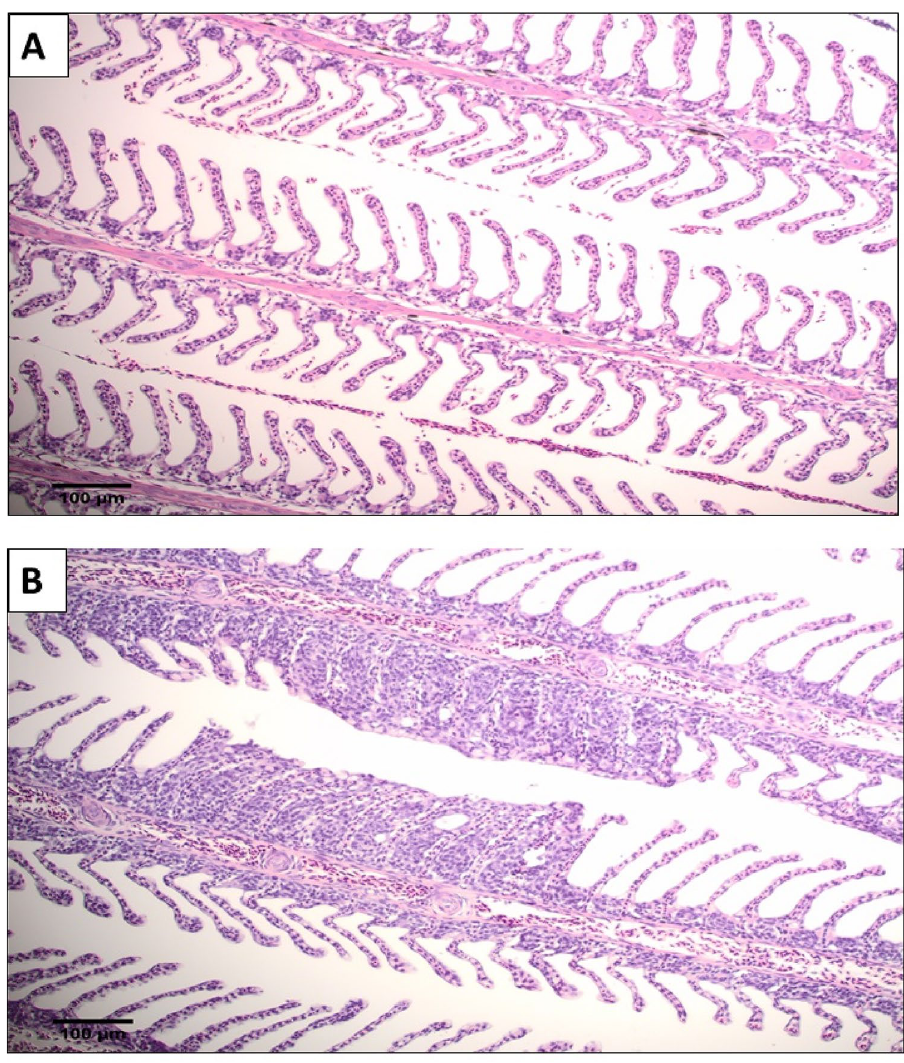
Figure 1. An example of H&E stained gill samples taken from non-AGD and AGD infected fish from the challenge trial. Scale bar = 100 µm. ( A ) Gill sample from the attenuated cohort. ( B ) Gill sample from the virulent